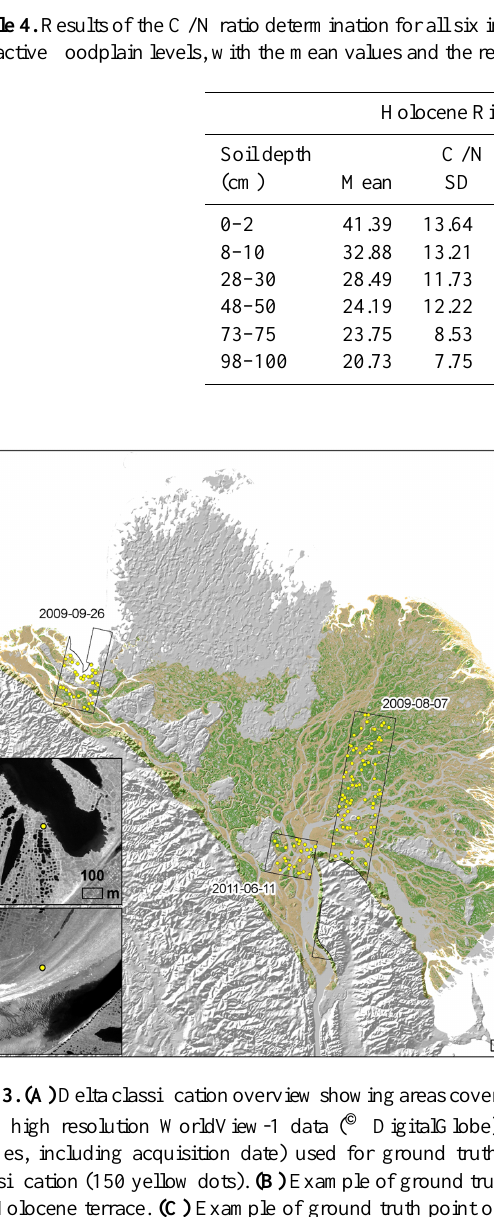
(98–100 cm), the C / N ratios were 21 ± 8 at the river terrace and 13 ± 2 at the floodplains,